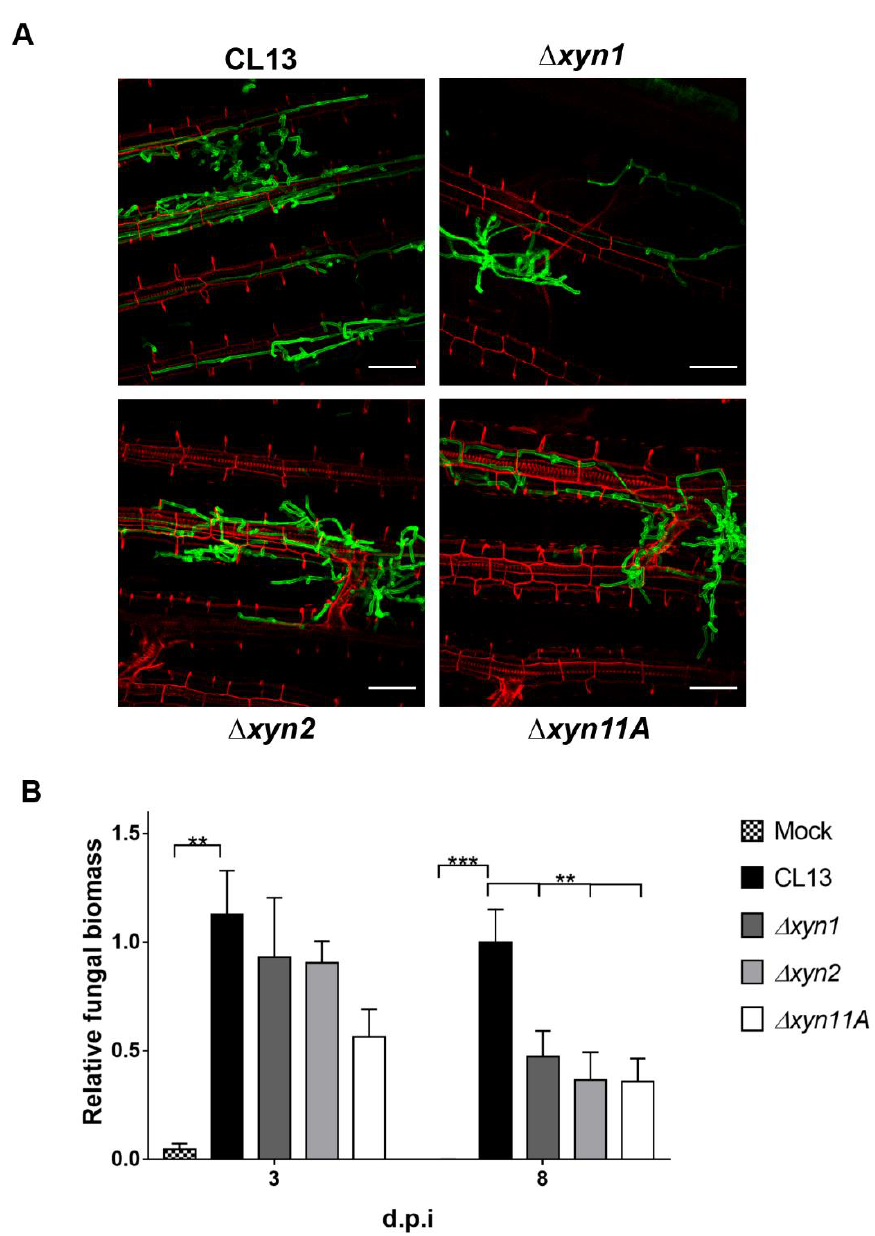
Figure 5. Fungal progression inside plant is impaired in the absence of xylanases. ( A ) Maize leaves from plants infected with CL13, CL13 ∆ xyn1 , CL13 ∆ xyn2 , and CL13 ∆ xyn11A strains at 3 dpi were stained with propidium iodide (red) and U. maydis hyphae with WGA-AF-488 (green) and visualized by fluorescence microscopy. Scale bar represents 43 µ m. ( B ) Fungal relative biomass in maize plants infected with indicated strains or water as mock treatment was quantified by qPCR. Four biological replicates were analyzed. T-test statistical analysis was performed (** p -value < 0.01; *** p -value < 0.001).